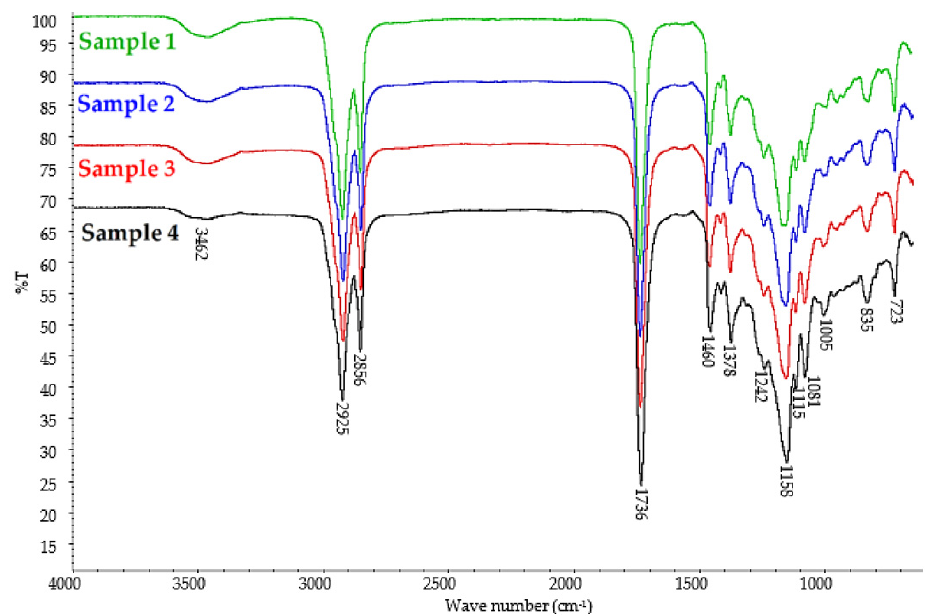
Figure 4. FT–IR spectra of epoxidized mixed esters (Samples 1–4).